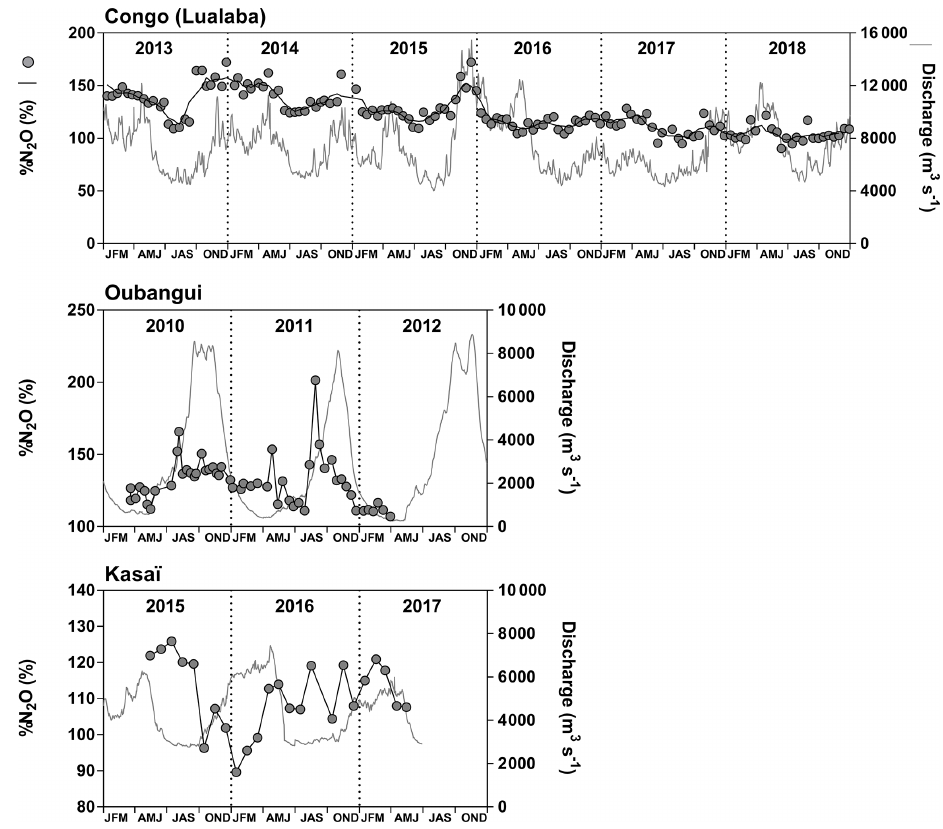
Figure 21. Time series of dissolved N 2 O saturation level (%N 2 O in %) in surface waters and freshwater discharge (grey line) in the Congo (at Kisangani, 2013–2018), the Oubangui (at Bangui, 2010–2012) and the Kasaï (at Dima, 2015–2017) rivers. The black line shows a five sample running average. Data in the Oubangui were previously reported by Bouillon et al. (2012, 2013).